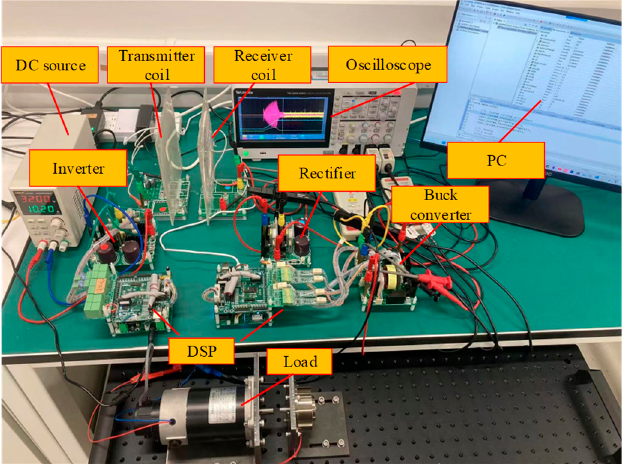
Figure 3. Real-time wireless transfer